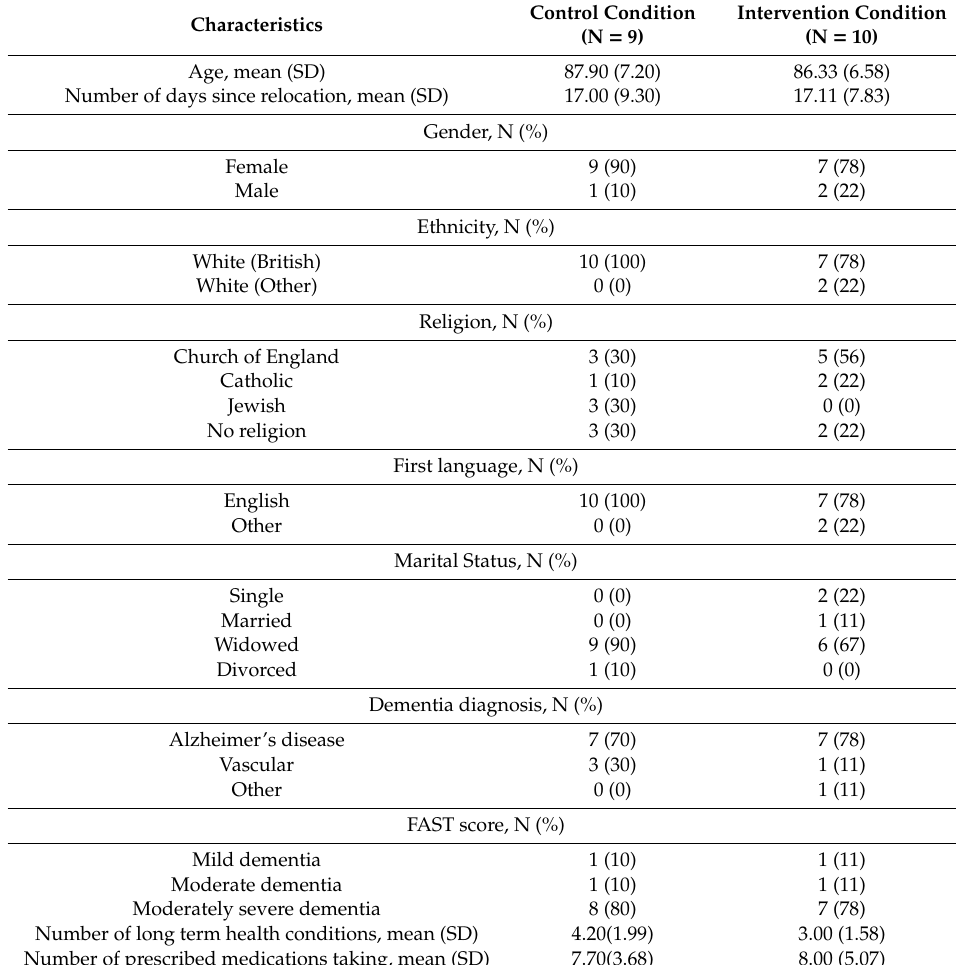
Table 5. Baseline resident demographic characteristics.